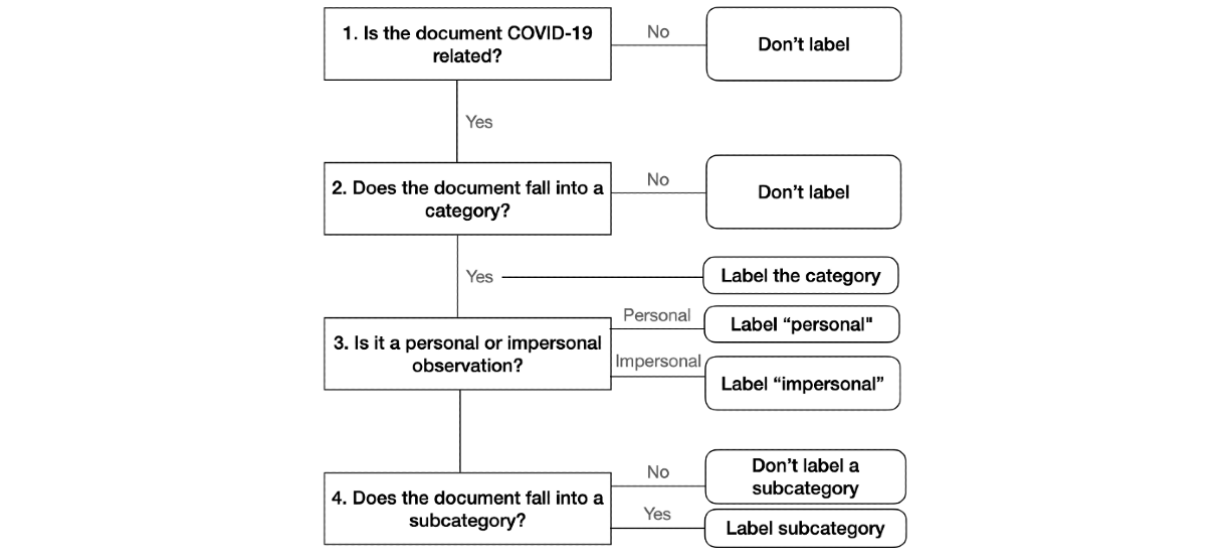
Figure 1. Decision tree for